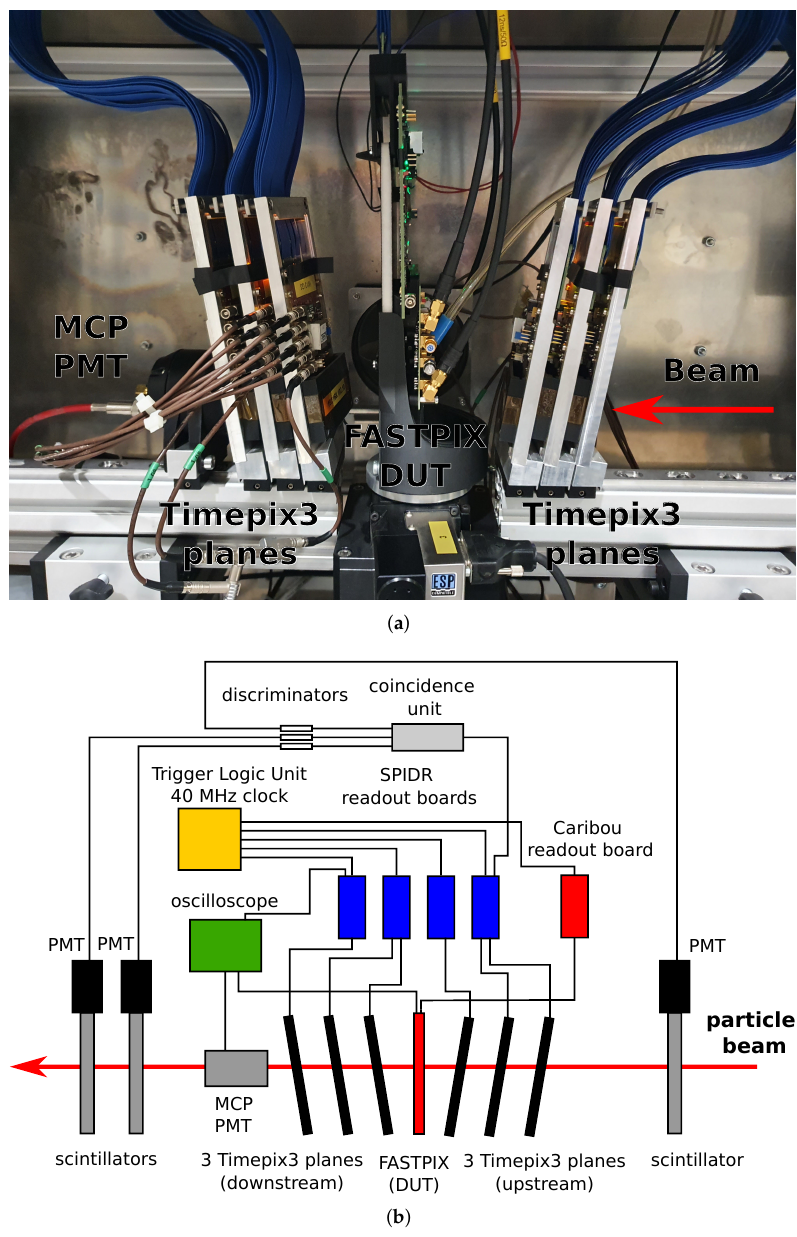
Figure 5. ( a ) Picture of the Timepix3 beam telescope with 6 Timepix3 reference planes, FASTPIX and MCP-PMT. ( b ) Schematic representation of the telescope and